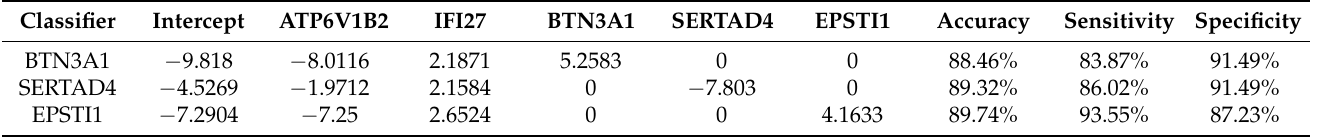
Table 1. First dataset: Characteristics of the top-performing individual genes together with ATP6V1B2 and IFI27 to form a three-gene classifier.